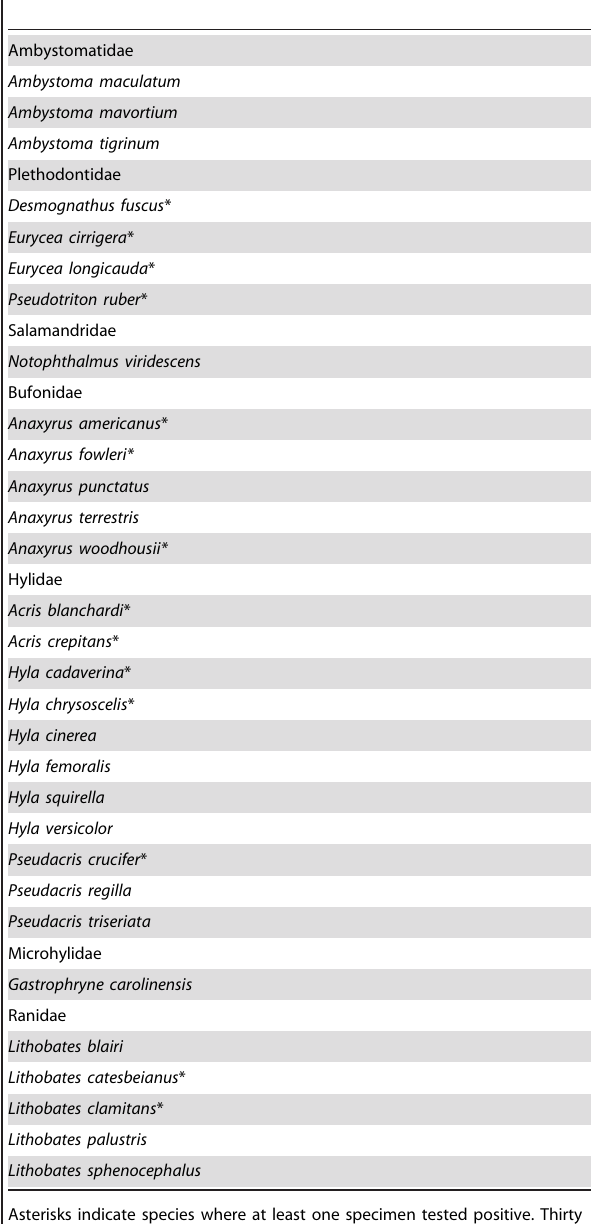
Table 3. AIC C scores for the top six (out of 23) candidate